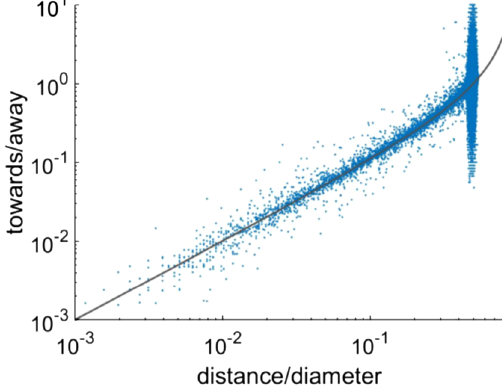
FIG. 4. Distribution of solutions in the sequence universe. A measure for the expansion in the functional sequence universe is the backward/forward ratio, the fraction of point mutations that make two sequences closer versus the ones that increase the distance [6]. The Hamming distances D (normalized by the 2550 ) show that most sequences reach universe diameter d max ¼ the edge of the universe, where no further expansion is possible. The black curve, D= ð 1 − D Þ , is the backward/forward ratio from purely random mutations.